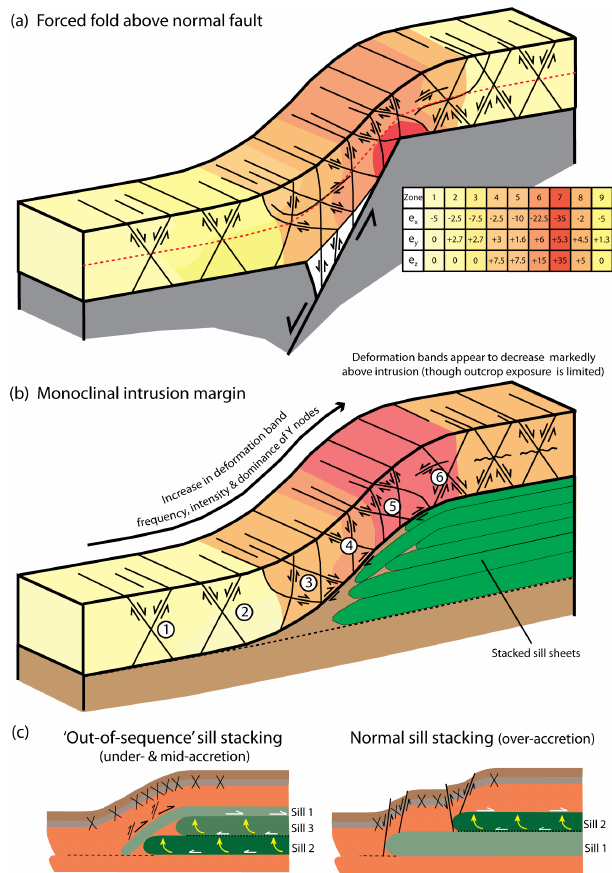
Figure 11. Schematic 3D block diagrams and cross sections com- paring the distribution of deformation structures. (a) A forced fold above a normal fault (modified after Ameen, 1990 and Cosgrove, 2015). (b) Deformation bands across the Trachyte Mesa intrusion (this study). (c) Cartoon showing varying deformation styles and distribution in relation to the order of sill sheet stacking (Wilson et al., 2016). In (a) the fold is divided into zones (see inset table) de- pending on the level of strain normal ( e z ) and parallel to the layer ( e y parallel to the fold hinge and e x normal to it). Note: extension is negative and contraction positive. Coloured zones highlighted in (b) are solely for visual purposes and do not correspond to the strain zones defined in (a)